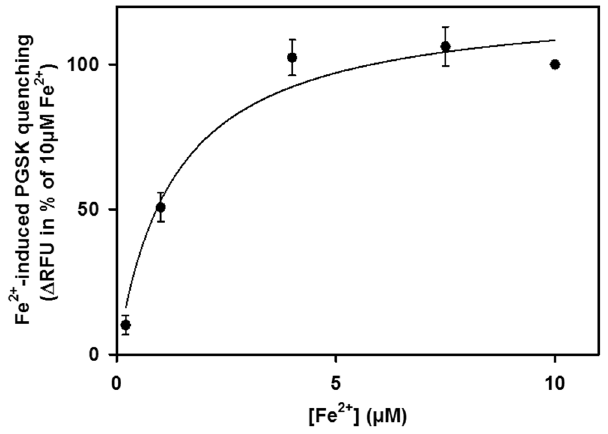
Figure 3. Apparent affinity of second phase Fe 2 + uptake in mitochondria from rDMT1-overexpressing HEK293 cells is consistent with DMT1-mediated transport. PGSK-loaded mitochondria (pH 7.6 i ) from doxycycline-induced rDMT1-HEK293 cells were assayed for quenching induced by increasing Fe 2 + concentrations. Fe 2 + was added from 500x concentrated FeSO 4 stock solutions, which had been supplemented with 50% cytosol, as detailed in Materials and Methods. The initial 20s-slopes of second-phase PGSK quenching ( −Δ PGSK), as described in Fig. 1, were normalized to values obtained at the maximally tested concentration of 10 µ M Fe 2 + . Data represent means ± SEM of 4–7 independent experiments. Data were fitted to a one-site saturation binding function, yielding a half-saturation concentration . fluorescence units.